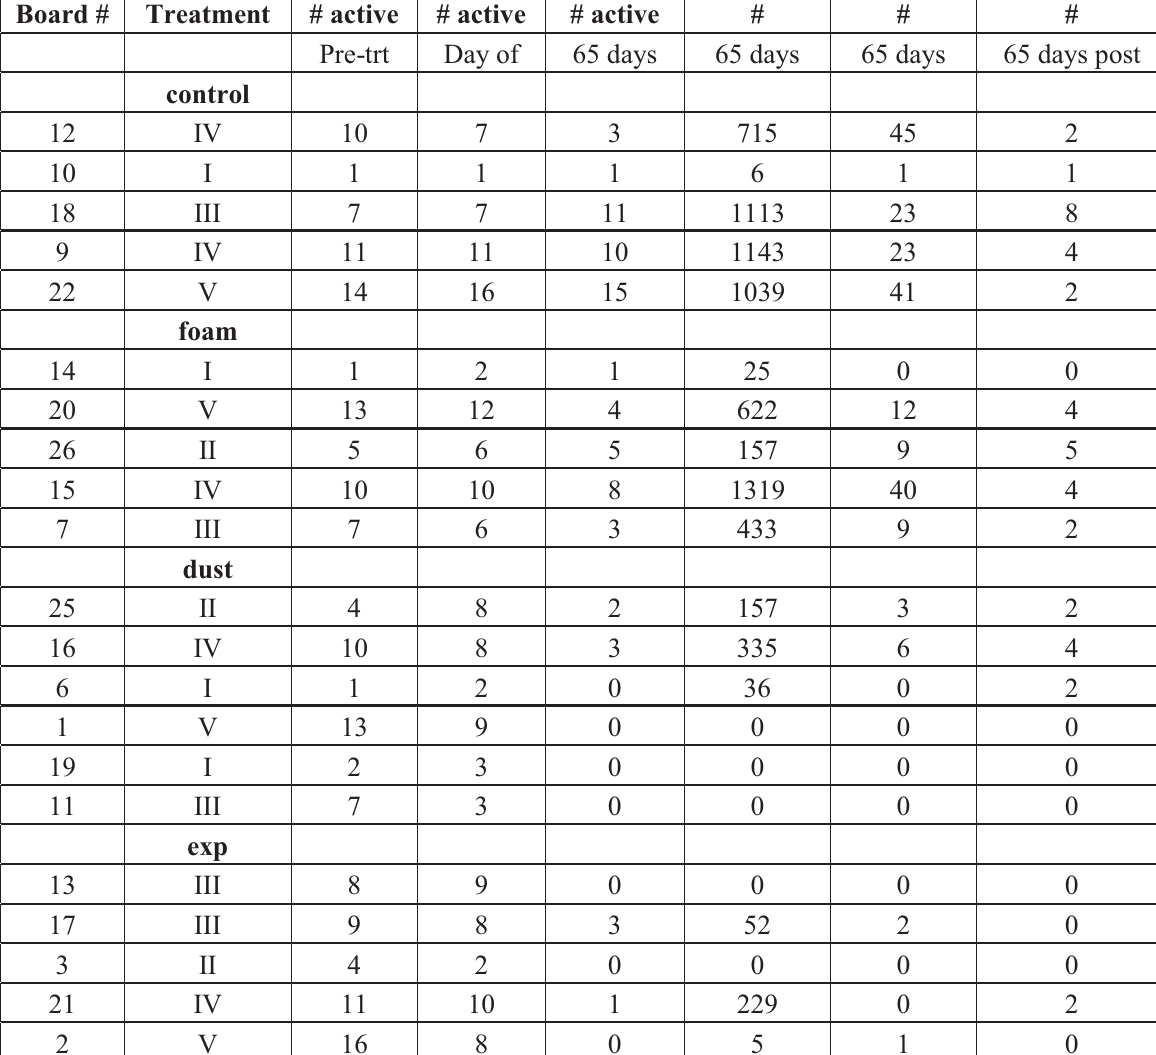
Table 1. Number of active sections by board as indicated by Termatrac readings on three separate days and the number of termites, by caste, found per board 65 days after treatment. Board #